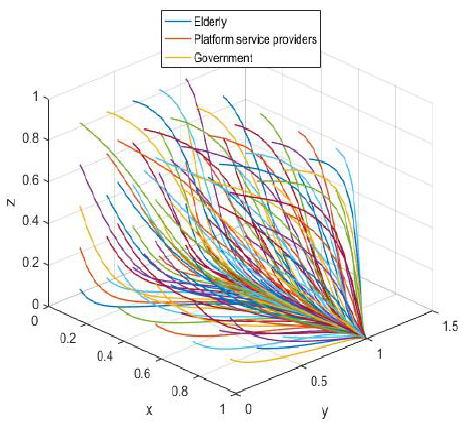
Figure 14. Trend graph for R e , F s , C 2 , and C 1 .